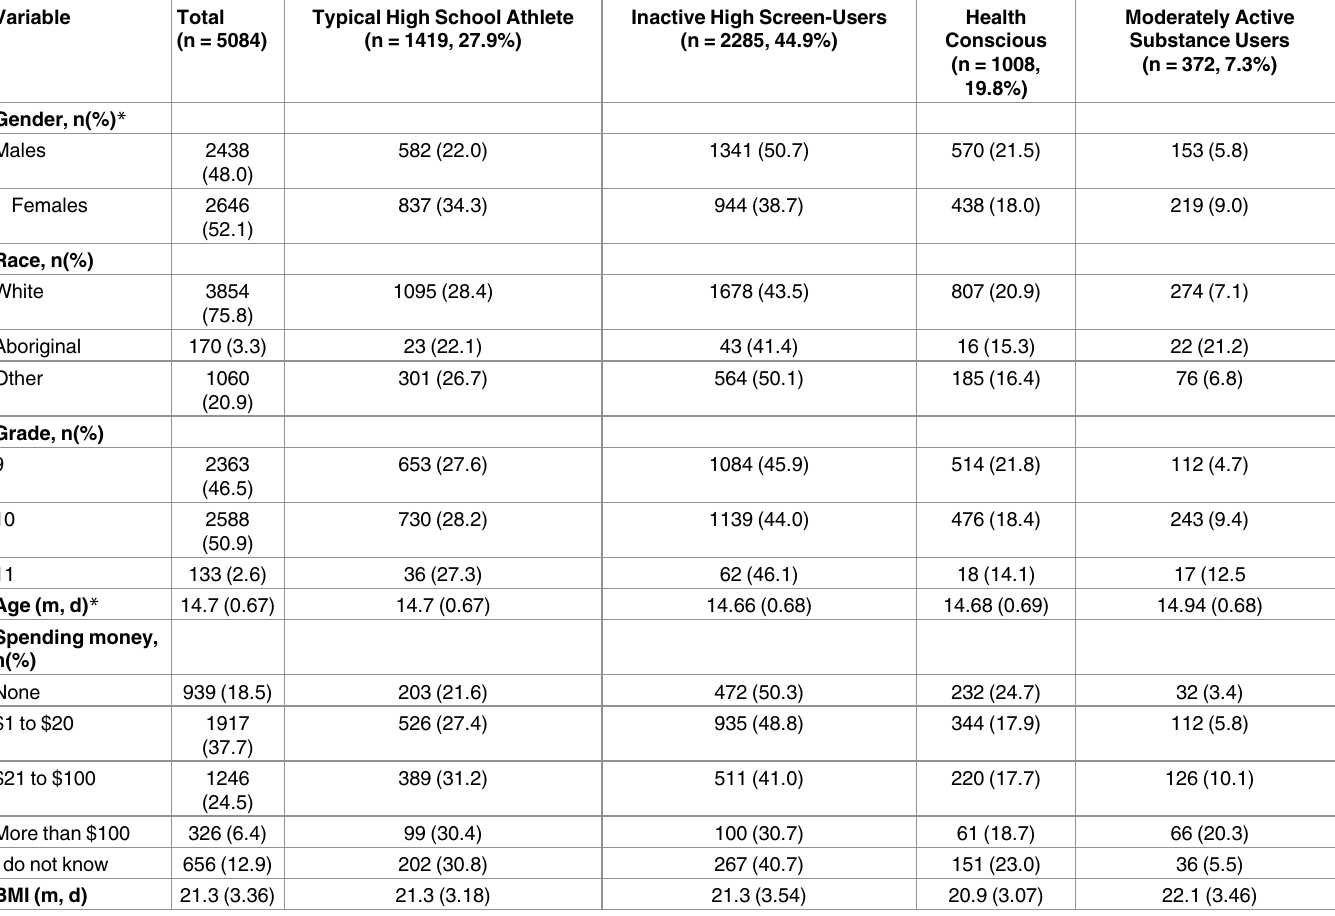
Table 2. Baseline characteristics of the linked-longitudinal sample of youth participating in Y 1 to Y 3 of the COMPASS study in Ontario, Canada (2012–2015).